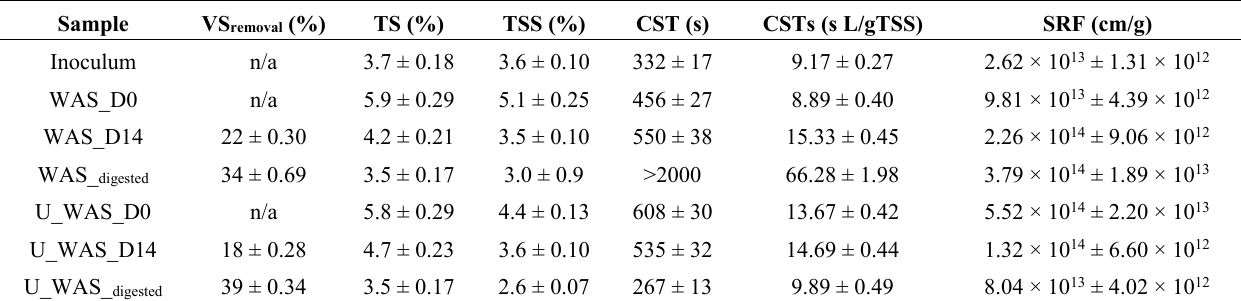
Table 3. Dewatering parameters for WAS during the digestion process.